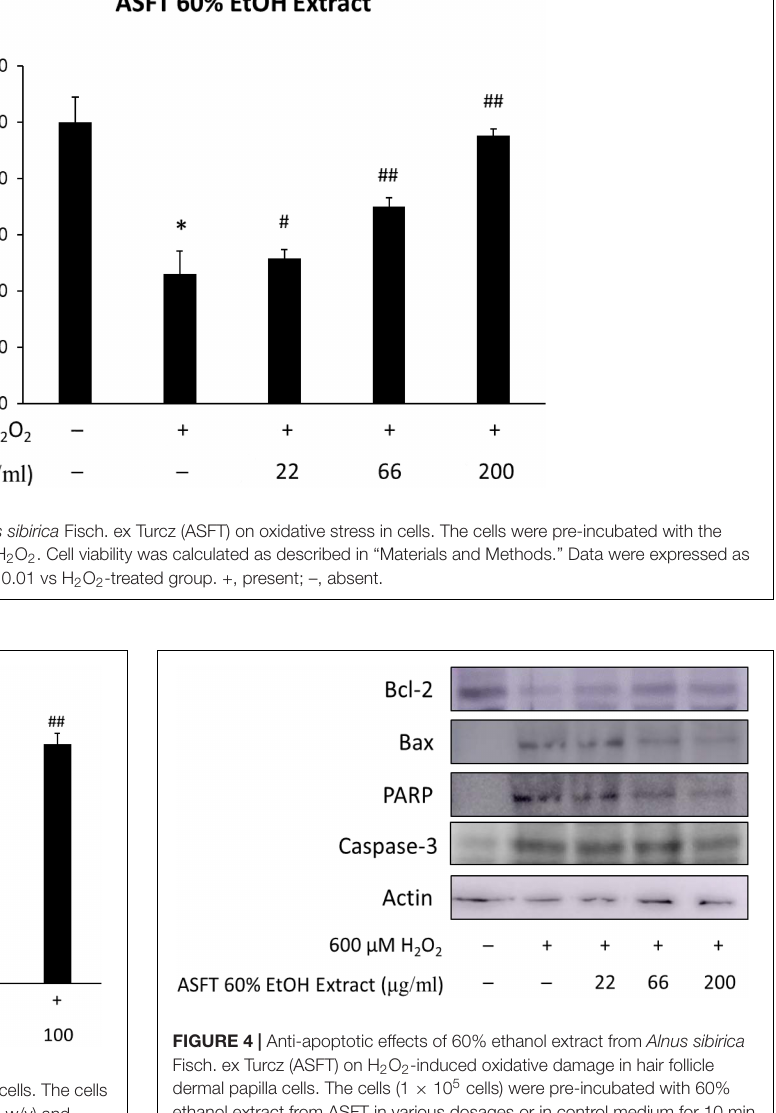
FIGURE 3 | Inhibitory effects of oregonin on oxidative stress in cells. The cells were pre-incubated with the indicated dose of oregonin ( µ g/ml, w/v) and treated with 600 µ M H 2 O 2 . Cell viability was calculated as described in “Materials and Methods.” Data were expressed as mean ± SD. * P < 0.05 vs normal group. # P < 0.05 and ## P < 0.01 vs H 2 O 2 -treated group. +, present; –, absent.